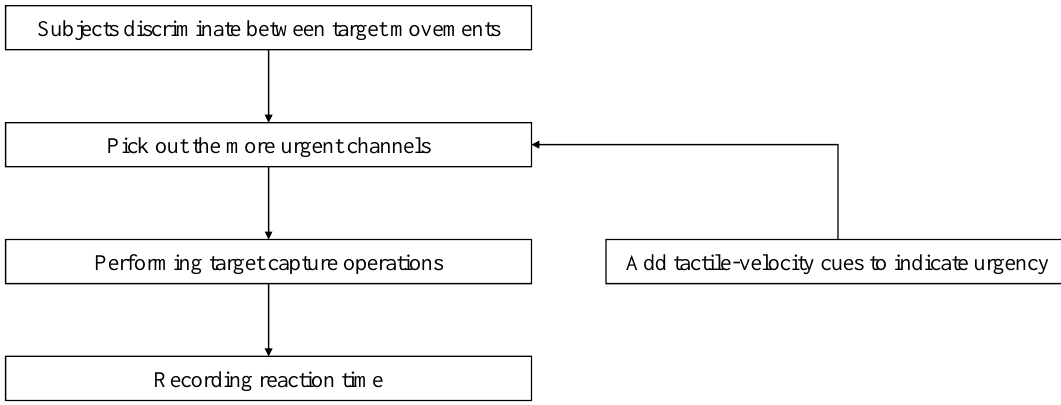
Figure 3. Process of Experiment 1.